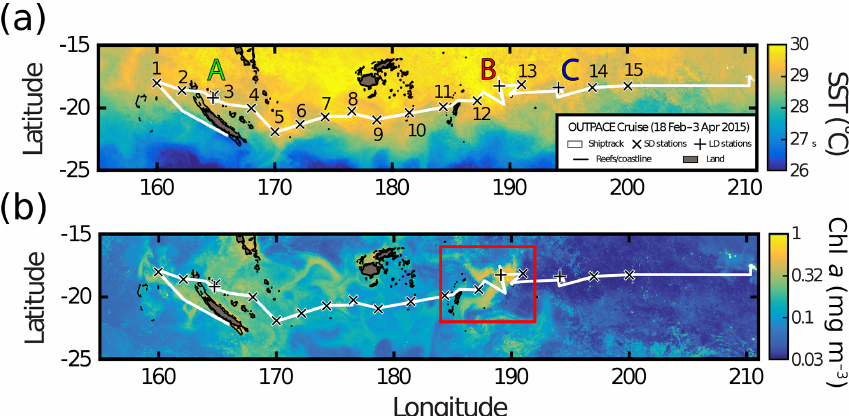
Figure 1. OUTPACE satellite (a) SST and (b) chl a . Satellite pixel data over 42 days are used to produce a weighted mean. The weight for each pixel is calculated by normalized inverse distance squared from the pixel to the daily mean ship position. The ship track, derived from SADCP data, is shown in white, while land is shaded gray, with black coastlines and reefs. Short-duration (SD) stations are depicted by black X marks, while long-duration (LD) stations are shown by black + signs. The LD stations are color-coded, using the convention for the OUTPACE cruise. A red rectangle in the chl a panel shows the study area for this